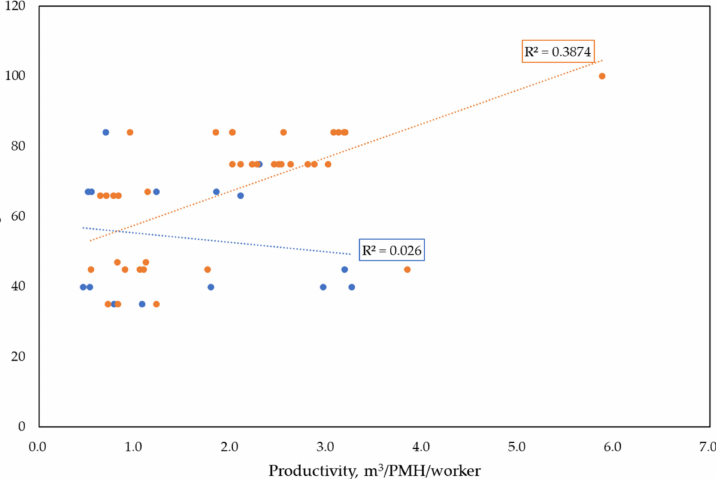
Figure 7. Productivity relationship with machine power. Productivity had a moderate correlation with two independent variables in clear-cut, whereas it had no correlation in the thinning